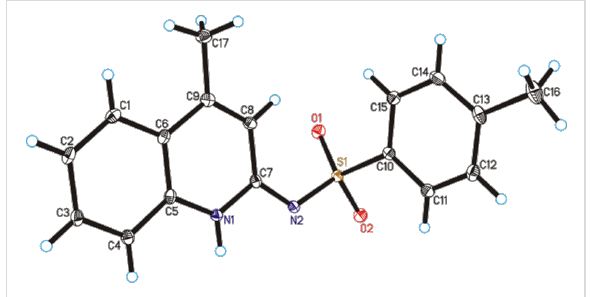
Figure 1: X-ray Structure of 9j (CCDC number